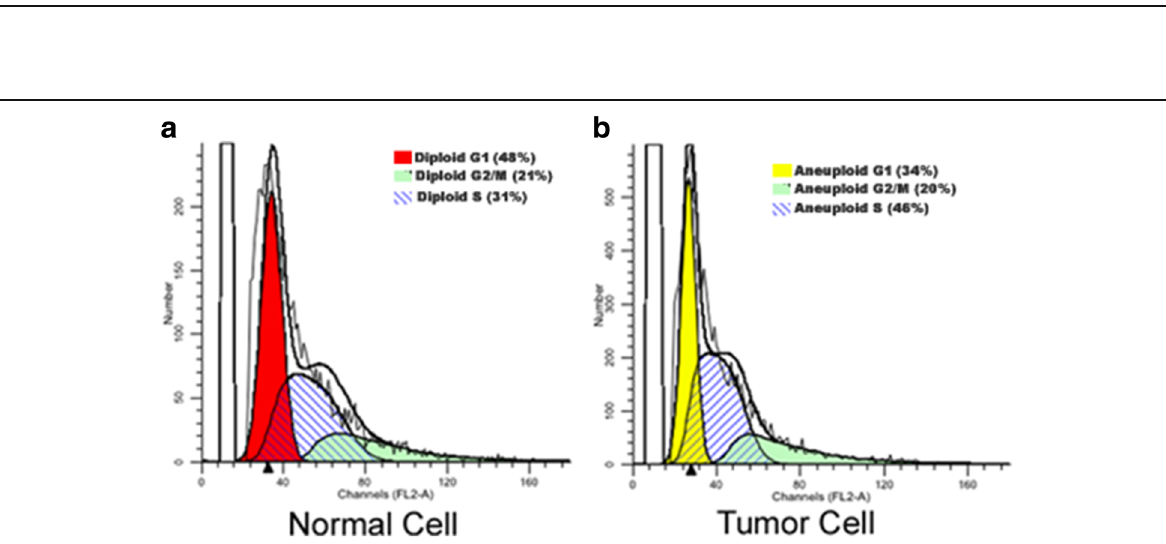
Fig. 3 Circos plot of representative APC mutation in gastric tumor sample and their association with cancer stages, cell cycle, and APC protein expression. The frequency of occurrence of different factors such as mutations, APC protein expression pattern, ploidy level and tumor stages is depicted in the outer ring. The inner ring of circos plot depicts the association between the mutations, APC protein expression pattern, ploidy level and tumor stage involved in gastric cancer. Each factor has been assigned a color. The arc originates from mutations and APC protein expression status and terminates at tumor staging and ploidy level to compare the association between the origin and terminating factors. The area of each colored ribbon depicts the frequency of the samples related with the particular mutations and APC protein expression